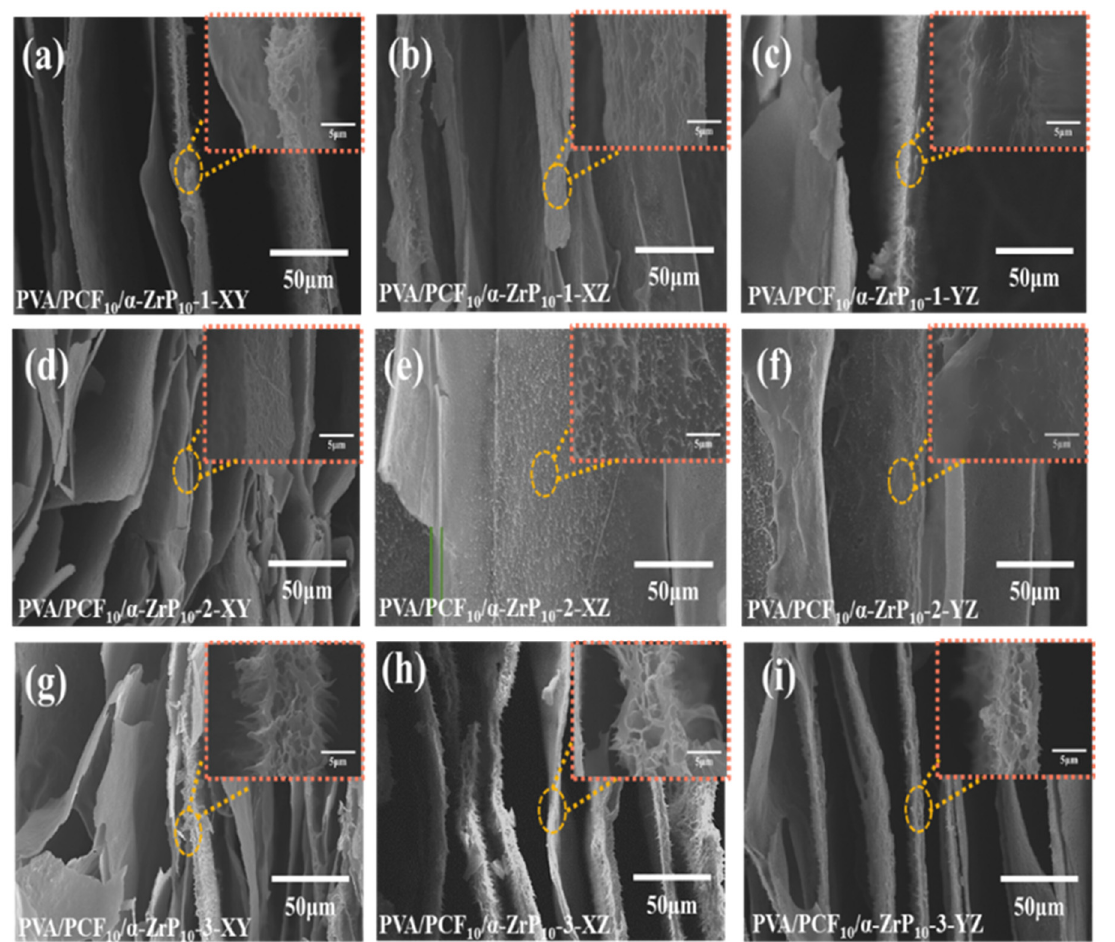
Figure 8. SEM images for the multi-directional PVA/PCF 10 / α -ZrP 10 -x aerogels. ( a ) PVA/PCF 10 / α - ZrP 10 -1-XY; ( b ) PVA/PCF 10 / α -ZrP 10 -1-XZ; ( c ) PVA/PCF 10 / α -ZrP 10 -1-YZ; ( d ) PVA/PCF 10 / α -ZrP 10 -2-XY; ( e ) PVA/PCF 10 / α -ZrP 10 -2-XZ; ( f ) PVA/PCF 10 / α -ZrP 10 -2-YZ; ( g ) PVA/PCF 10 / α -ZrP 10 -3-XY; ( h ) PVA/PCF 10 / α -ZrP 10 -3-XZ; and ( i ) PVA/PCF 10 / α -ZrP 10 -3-YZ.